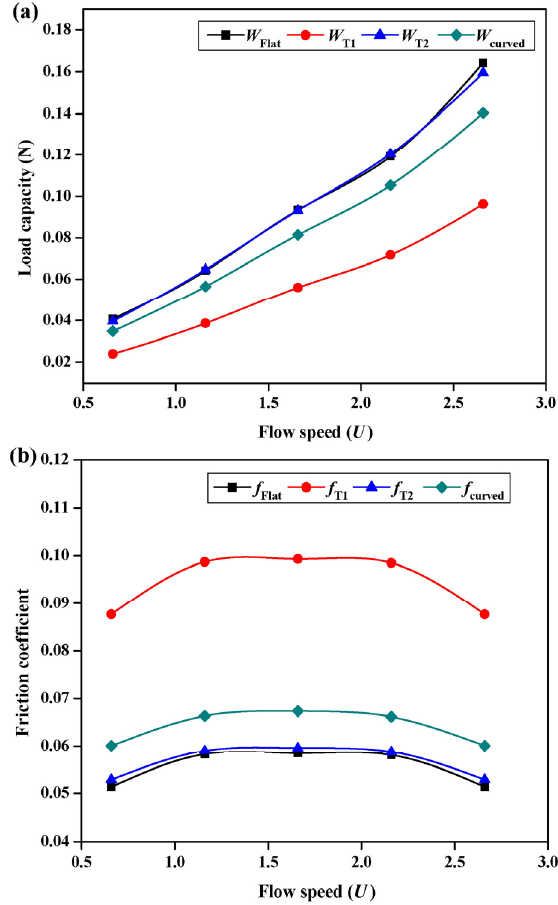
Fig. 9 Effect of flow speed on (a) load capacity and (b) friction